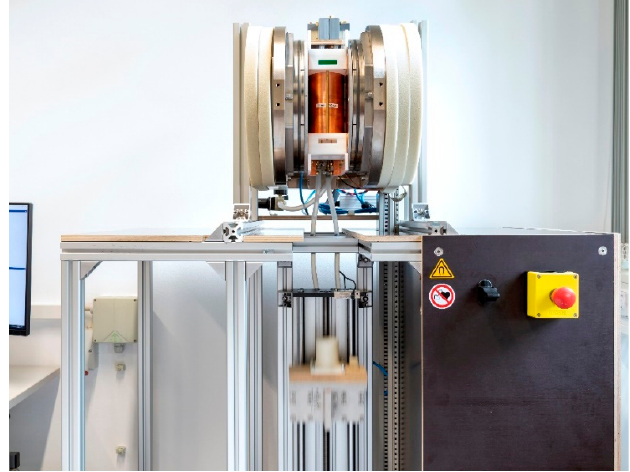
Figure 3. Photograph of the NMR tomograph at BAM. Source: BAM.